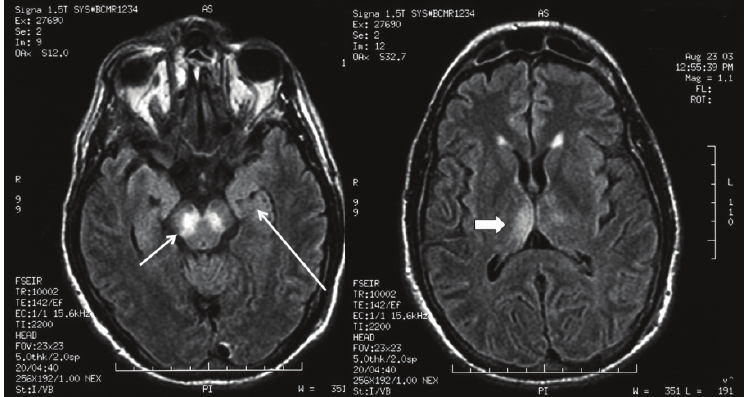
Figure 2. Fluid-attenuated inversion recovery magnetic resonance imaging sequence of the brain in a patient with West Nile virus encephalitis with associated parkinsonism and tremor, displaying signal abnormality in the substantia nigra (short arrow), the mesial temporal lobe (long arrow) and right posterior thalamus (thick